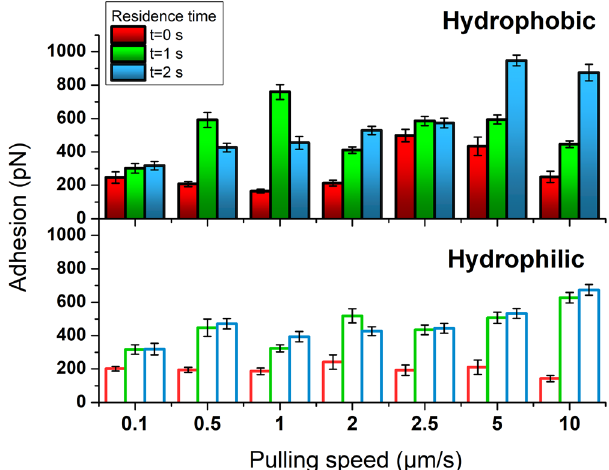
Figure 1. Adhesion force between a silicon nitride tip (hydrophobic –top- and hydrophilic –bottom-) and the mucin film at pH 7.0, under varying contact/residence (dwell) time and pulling rate. Error bars indicate the mean error for N > 50